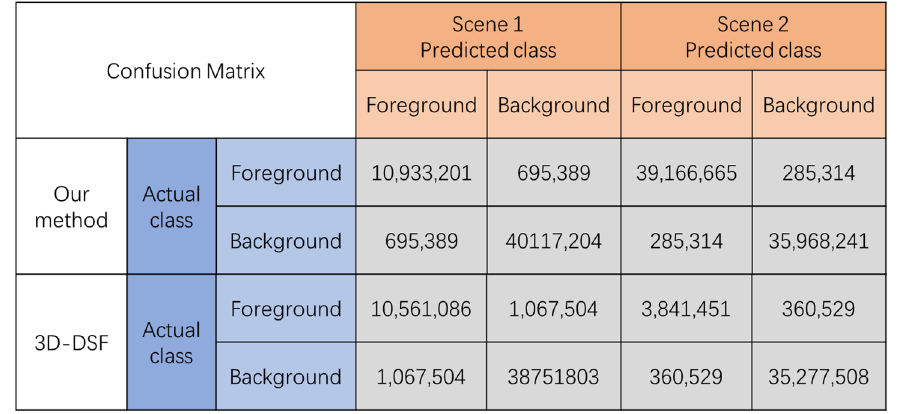
Figure 17. CM on two scenes using our method and 3D-DSF at long distances.